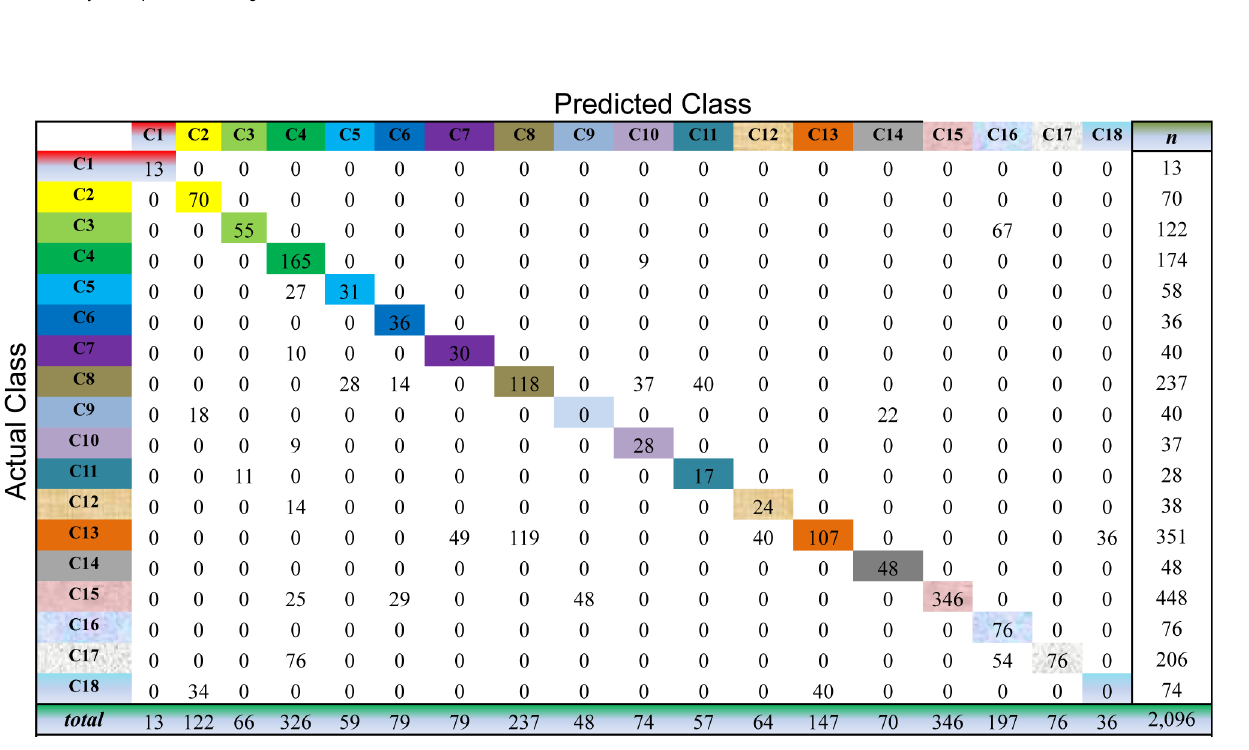
Fig 11. Confusion matrix of prediction results using CNMF, which achieves a total accuracy of 66.41%. Matrix delineates distribution of actual compared with predicted class membership for multiclass cancer prediction on the Acute Leukemia dataset.